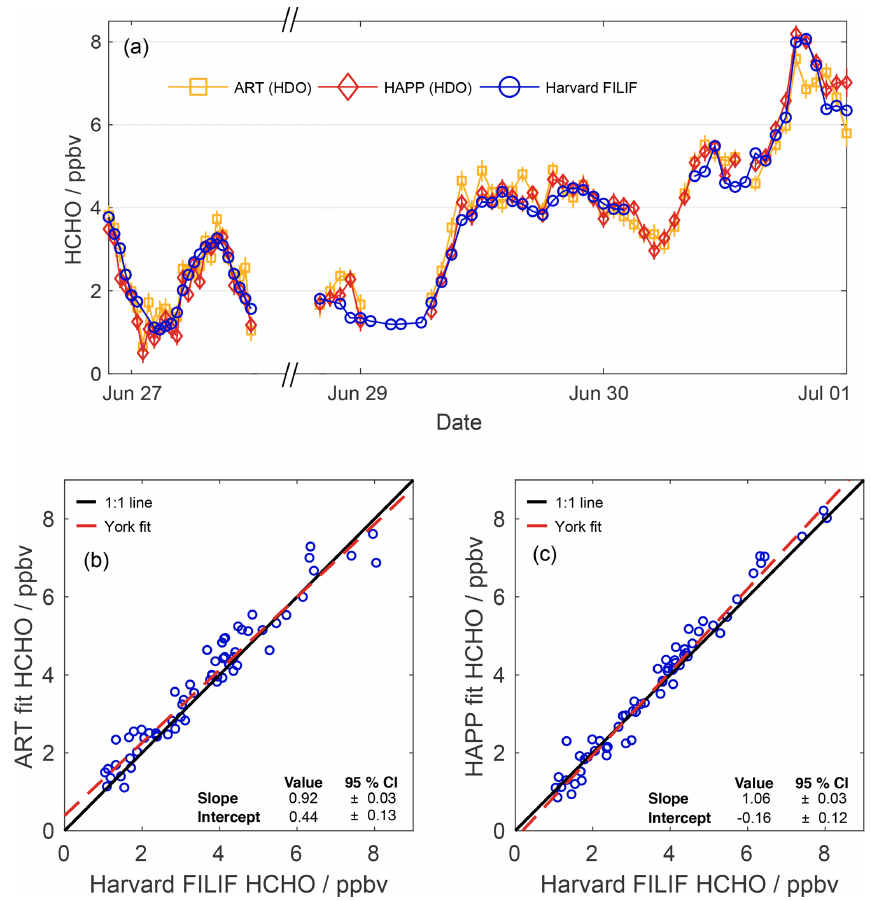
Figure 6. (a) Collocated, multiday sampling of ambient air in Cambridge, MA, by Harvard FILIF and the Aeris sensor (HDO mode). Ticks represent midnight (00:00) on the specified date. All data are reported with an integration time of 60min. From the evenings of 27 to 28 June, the area experienced rain showers that caused both the ART and HAPP fits to underestimate the HCHO mixing ratio by ∼ 0 . 5ppbv due to water condensing on the optics. Data from the Aeris sensor were also removed (1) during the early hours of 29 June due to replacement of the DNPH cartridge and (2) during the afternoon of 30 June due to zeroing of the sensor with ultra-zero air. Correlation plots comparing Harvard FILIF with (b) ART fit ( R 2 = 0 . 940) and (c) HAPP fit ( R 2 = 0 . 974).